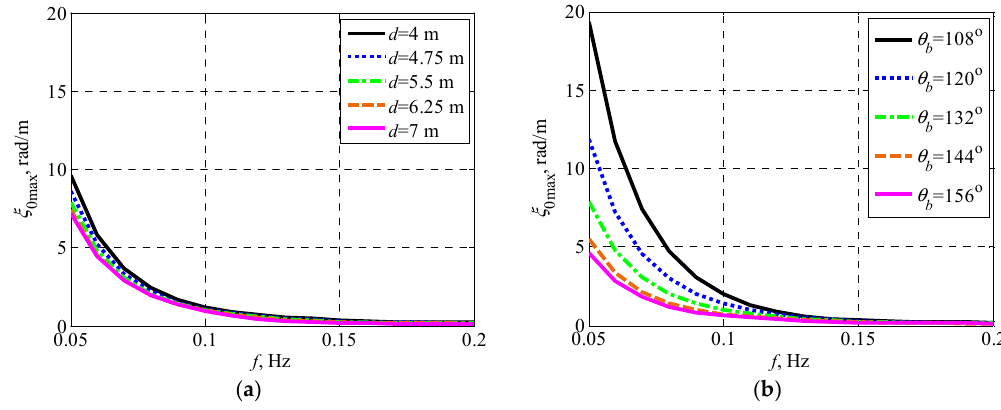
Figure 10. Response amplitude operator (RAO) of the Duck at maximum relative capture width as a function of wave frequency at different floating states: ( a ) for fixed beak angle at θ b = 144°; and ( b ) for fixed depth of rotation axis at d = 5.5 m. Table 2. Value of beak angle at different tidal heights.